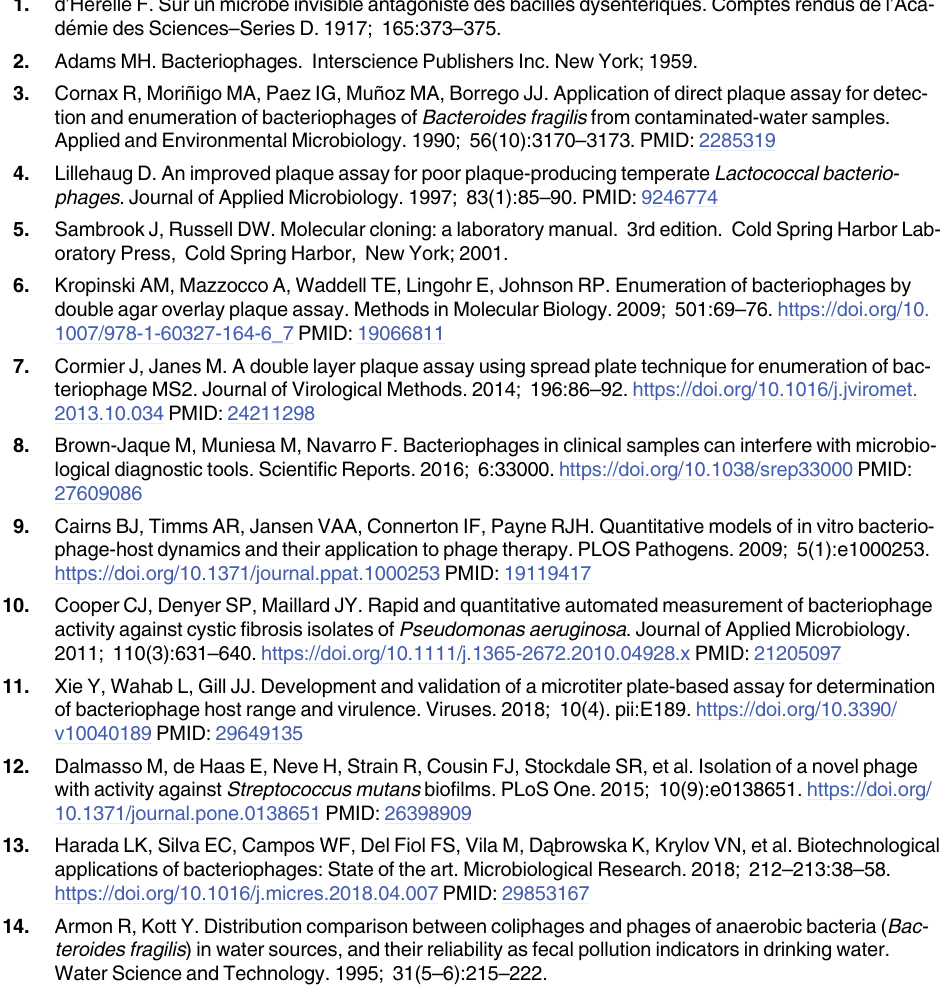
S1 Dataset. Contains the optical density (OD) vs time data corresponding to 90 different phage/bacteria combinations. Data have been used to build the graphs in Supplemental S1 Fig. A subset of the data has been used for Fig 2 of the